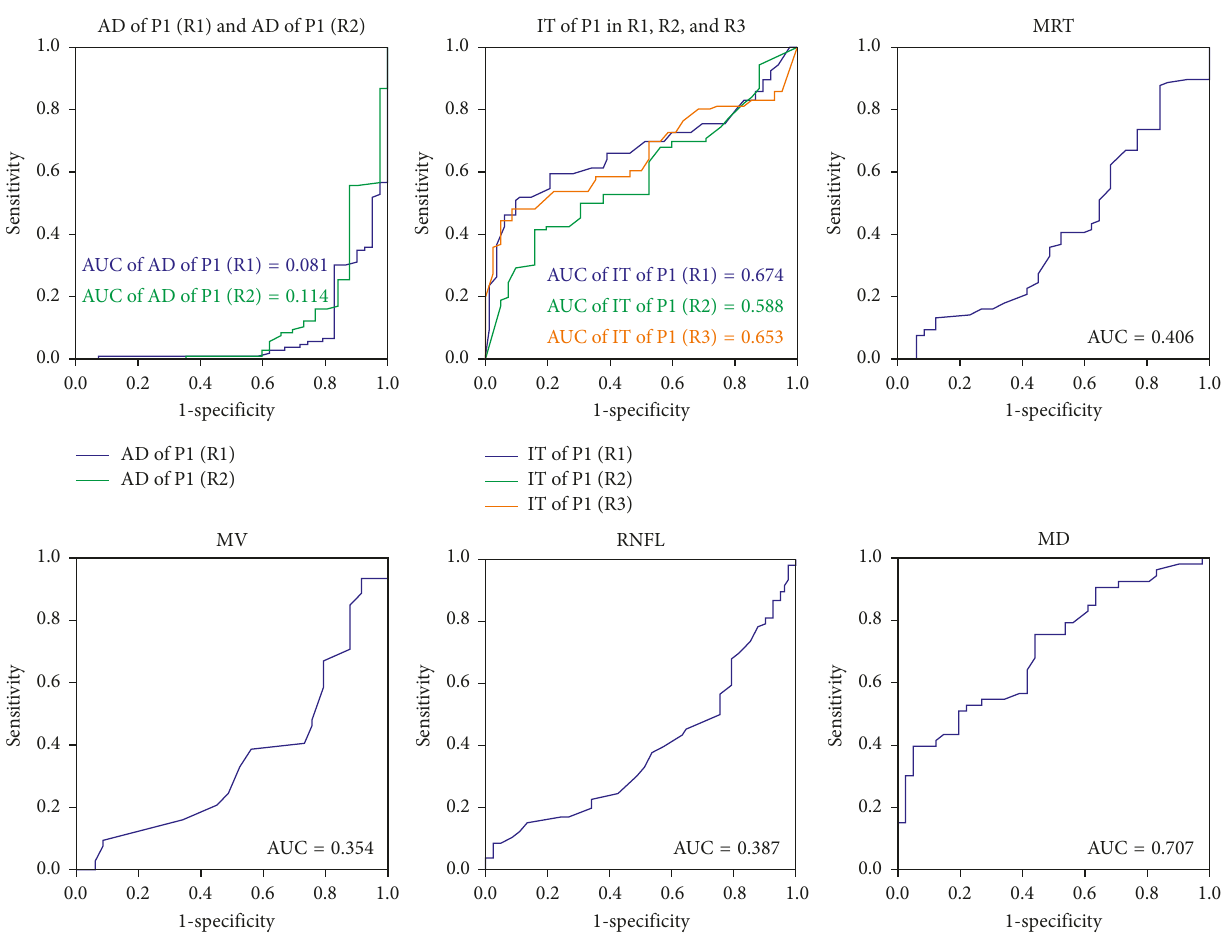
Figure 1: ROC curves of the single parameter of visual function or structure for discriminating Parkinson’s disease. AD � amplitude density; IT � implicit time; R1 � ring1; R2 � ring2; R3 � ring3; MD � mean deviation of visual field; MRT � macular retinal thickness; MV � macular volume; RNFL � retinal nerve fiber